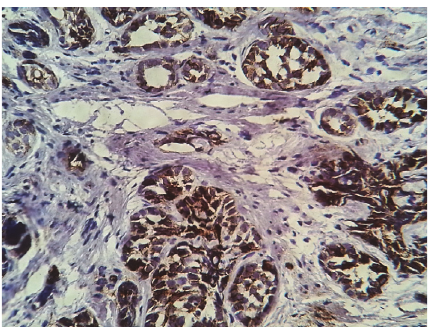
Figure 3: Immunostaining with CD 117: the adenoid cystic carci- noma cells are positive.